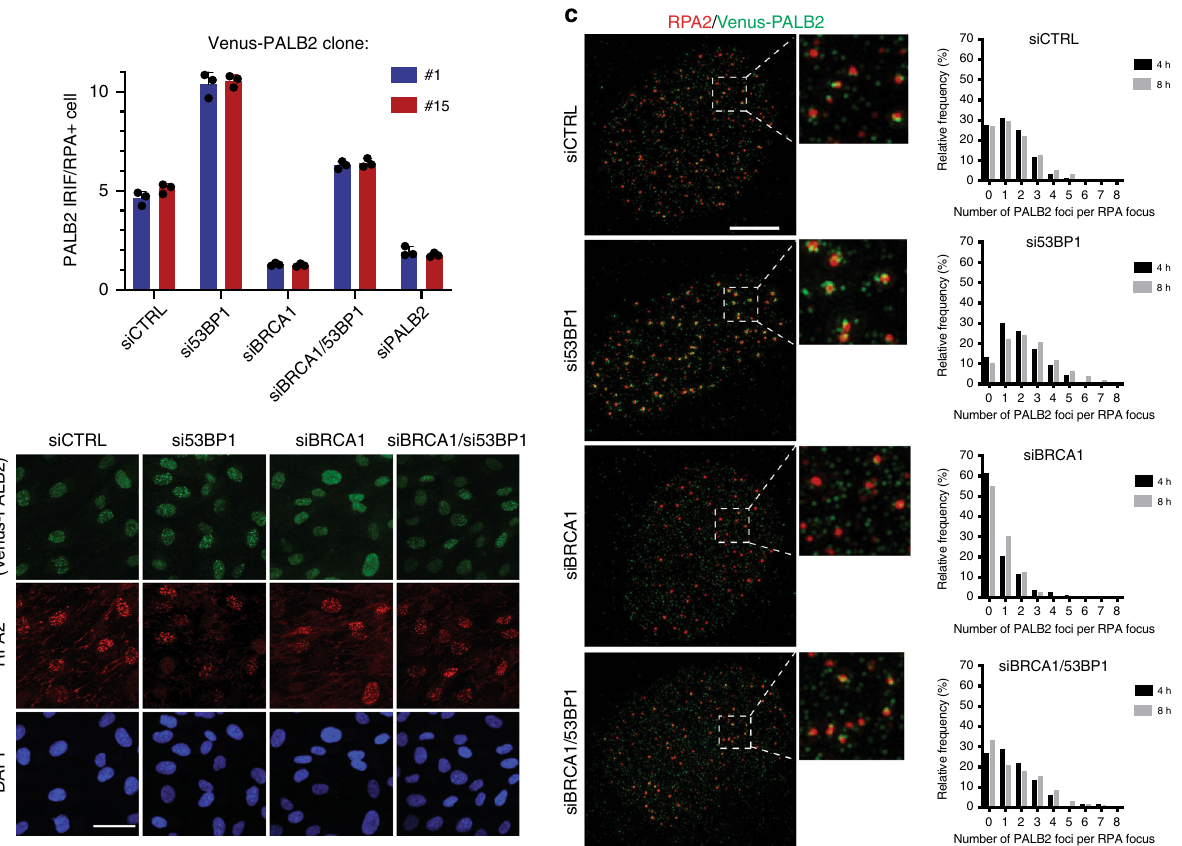
Fig. 2 53BP1 depletion rescues PALB2 focus formation in BRCA1-de fi cient cells. a Quanti fi cation of Venus-PALB2 IRIF in RPA focus-positive RPE1 cells. Two independently generated RPE1 Venus-PALB2 cell lines (#1 and #15) were siRNA-depleted for indicated proteins, exposed to 6 Gy of IR and 6 h later, fi xed and stained with anti-GFP and anti-RPA2 antibodies. Imaging and IRIF quanti fi cations were performed in three independent experiments, using OPERA Phoenix HT microscope. b Representative images, acquired on OPERA Phoenix HT microscope, of RPE1 cells with endogenously Venus-tagged PALB2 gene. The cells were stained with anti-GFP (to enhance the signal of the Venus tag) and anti-RPA2 antibodies. Scale bar, 50 µ m. c Venus-PALB2 association with RPA fi laments in cells depleted for 53BP1. RPE1 cells expressing endogenously tagged Venus-PALB2 were depleted for BRCA1 and/or 53BP1, irradiated with 6 Gy of IR and, 8 h later, processed for immuno fl uorescence analyses. Images were acquired using super-resolution 3D-SIM OMX microscope. Scale bar, 5 µ m. Graphs to the right of the images represent distribution of relative frequencies of Venus-PALB2 foci numbers adjacent to each RPA focus. Source data are provided as a Source Data fi